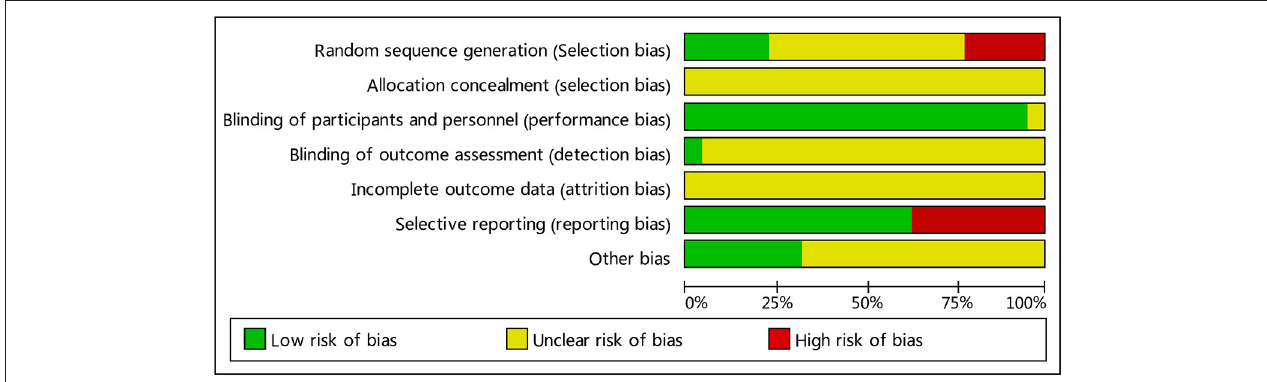
FIGURE 2 | Bias risk map: the reviewers’ judgment of each type of bias risk, expressed as a percentage of all included studies.